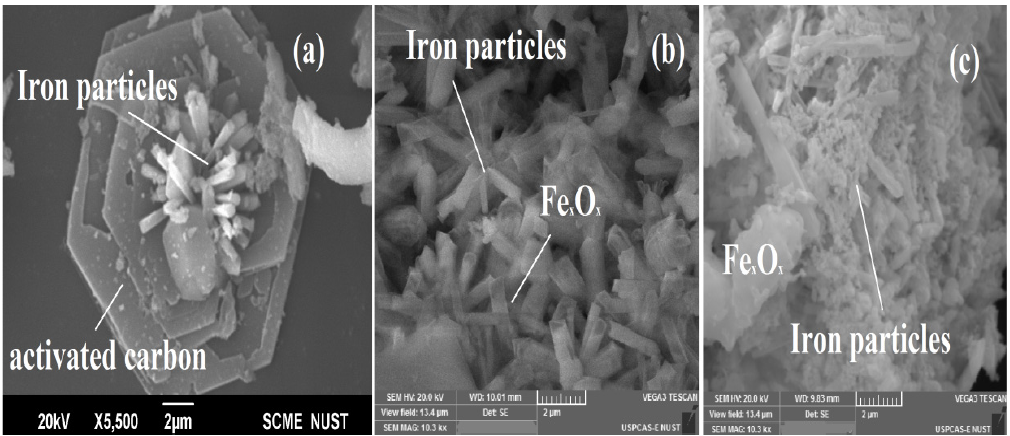
Figure 3. Scanningelectron microscopy of Fe-C catalyst ( a ), Fe-C LT-FTS ( b ), and Fe-C HT-FTS ( c ) .